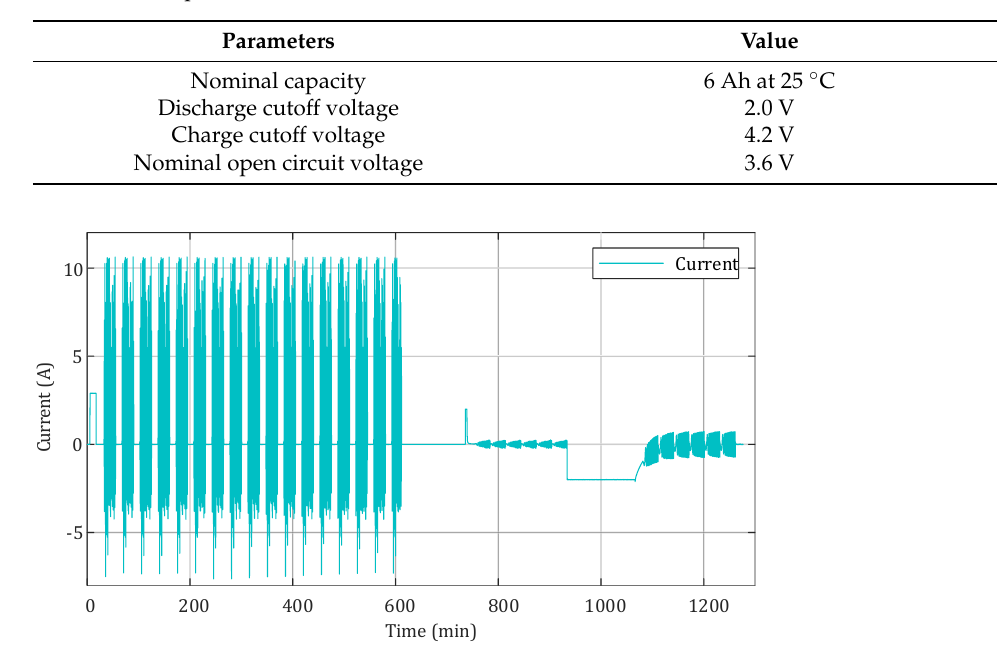
Table 2. Main specifications of the under-test cell.